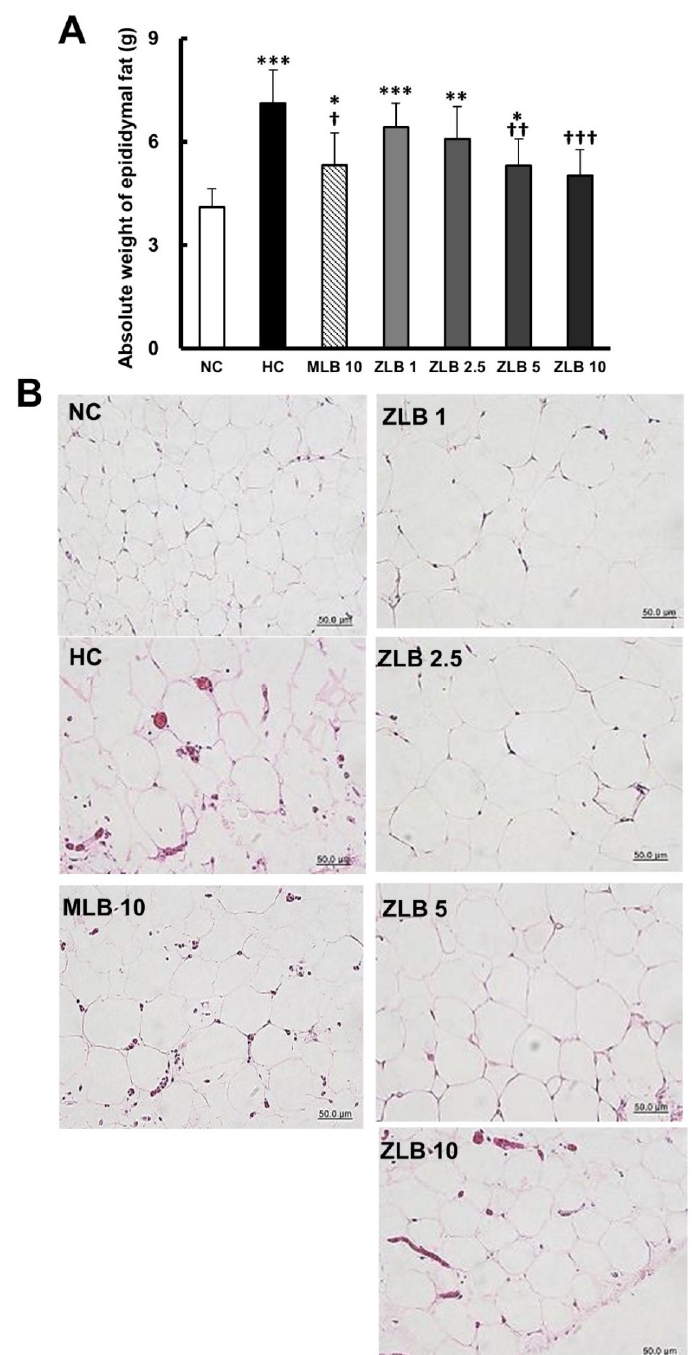
Figure 3. Effects of MLB and ZLB on epididymal fat. The rats were sacrificed at the end of the experiment (a month). Weight of the epididymal fat was measured ( A ), and representative photomicrographs of epididymal fat tissues are shown at a magnification of ×400 ( B ). NC, normal diet control; HC, high-fat-diet (HFD) control; MLB10, HFD with 10 mg/kg/day of MLB; ZLB1, ZLB2.5, ZLB5, and ZLB10, HFD with 1, 2.5, 5, and 10 mg/kg/day of ZLB. Values are expressed as mean ± SD (n = 6 per group). * P < 0.05, ** P < 0.01, and *** P < 0.001 vs. NC group; † P < 0.05, †† P < 0.01, and ††† P < 0.001 vs. HC group.